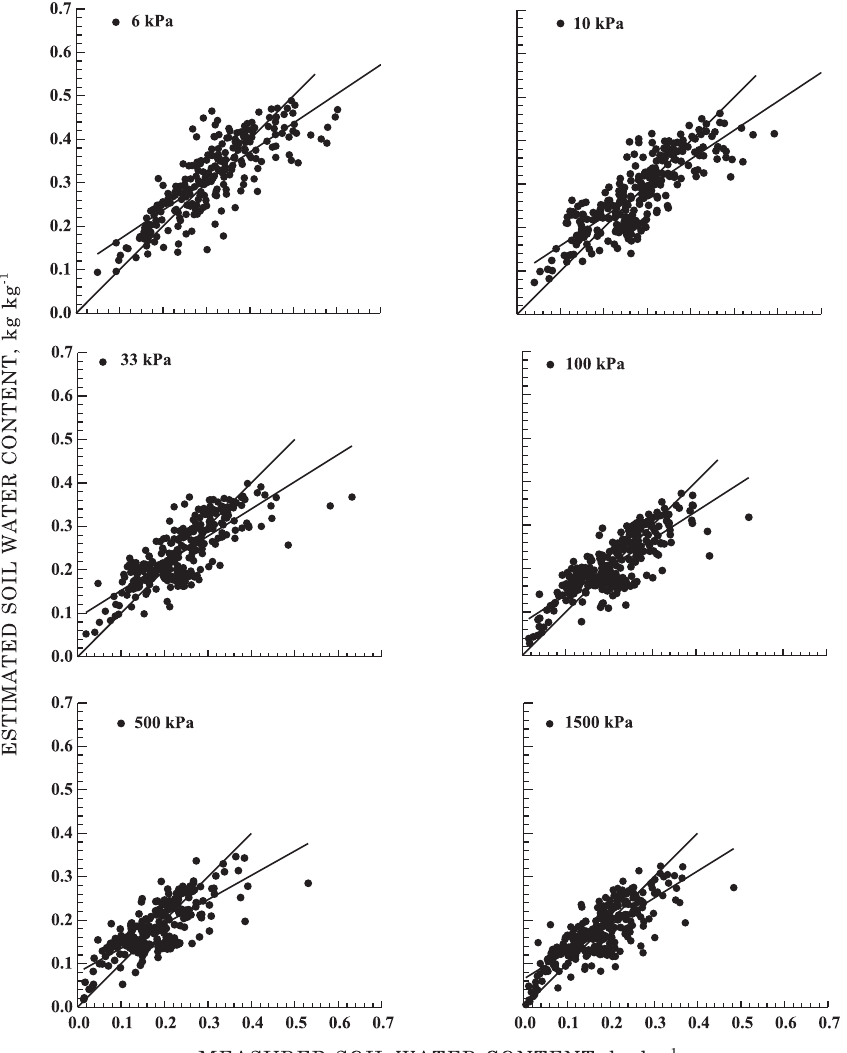
Figure 2. Relationship between the soil water content estimated by the pedofunctions proposed in table 4 and the soil water content measured in the laboratory for the tensions of 6, 10, 33, 100, 500 and 1,500 kPa in some RS soils. The straight line from the origin represents the 1:1